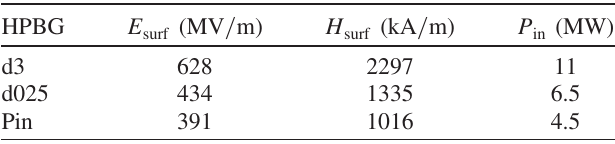
TABLE III. Comparison of the peak surface E and H fields of the HPBG structures for a 100 MV = m accelerating gradient.